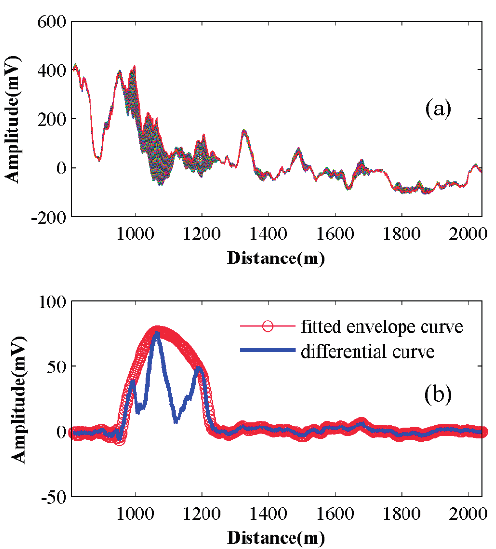
Figure 5. ( a ) Fifty after-averaged traces superimposed with amplitude change from 970 m to 1270 m. ( b ) Differential trace (the blue solid line) and its fitted envelope curve (the red circular line).